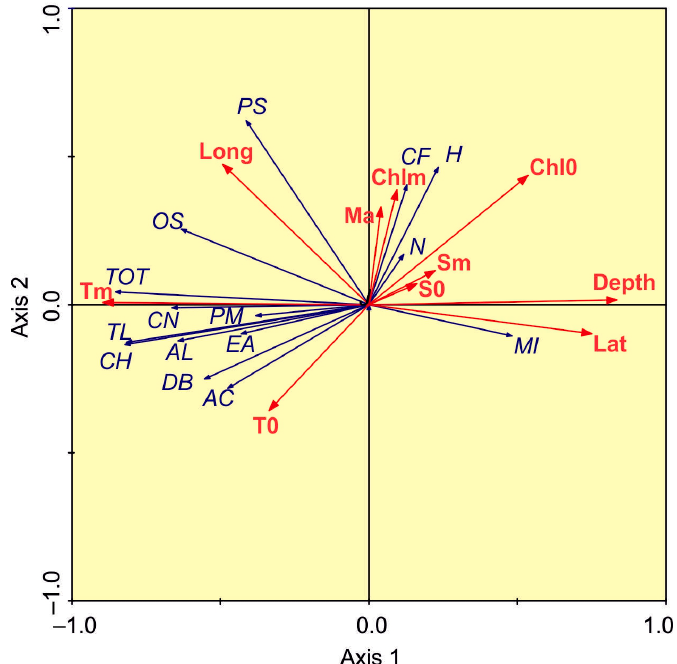
Figure 6. Ordination of samples by redundancy analysis based on copepod abundance and its relation to environmental variables (red arrows) in the south-eastern Barents Sea in summer 2012. The most frequent taxa are indicated in the plot. Biological variables (square-root-transformed